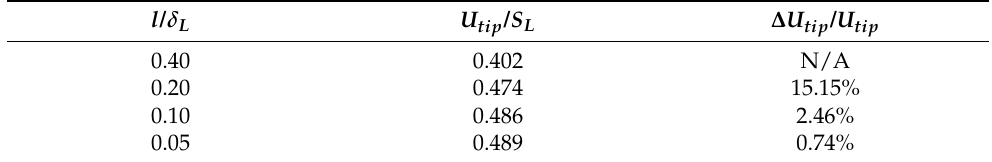
Table 1. Resolution tests for the flame flashback speed U tip ( θ = 8, B = 10, R = 60 δ L , U max = 3 S L ).